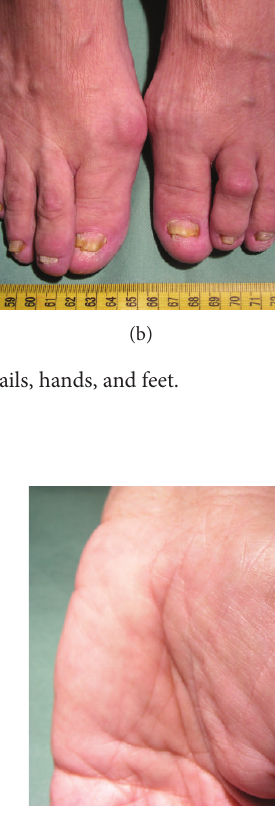
Figure 2: Pigment dots on palms.